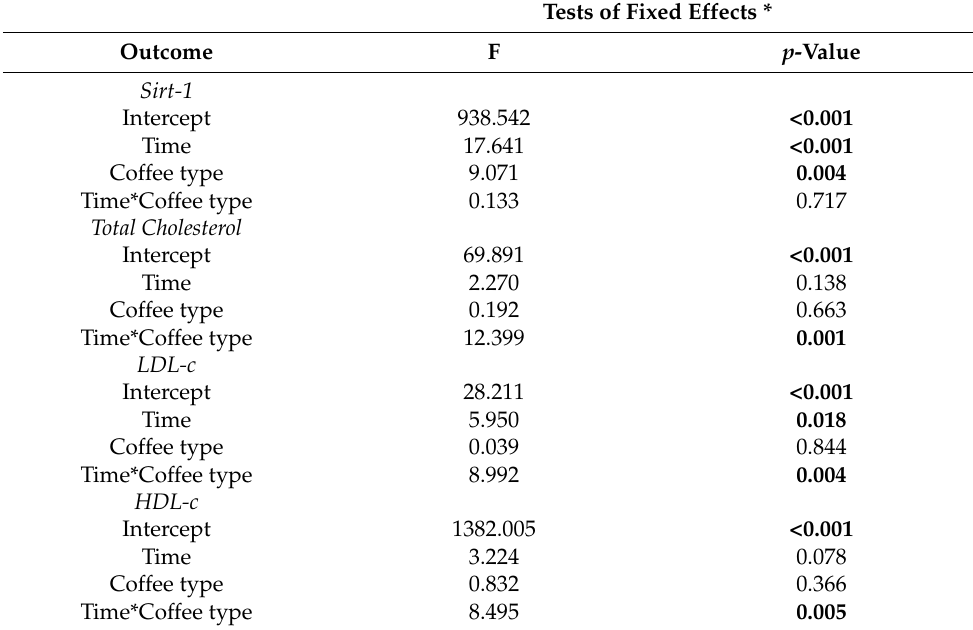
Table 3. Effects of interventions on